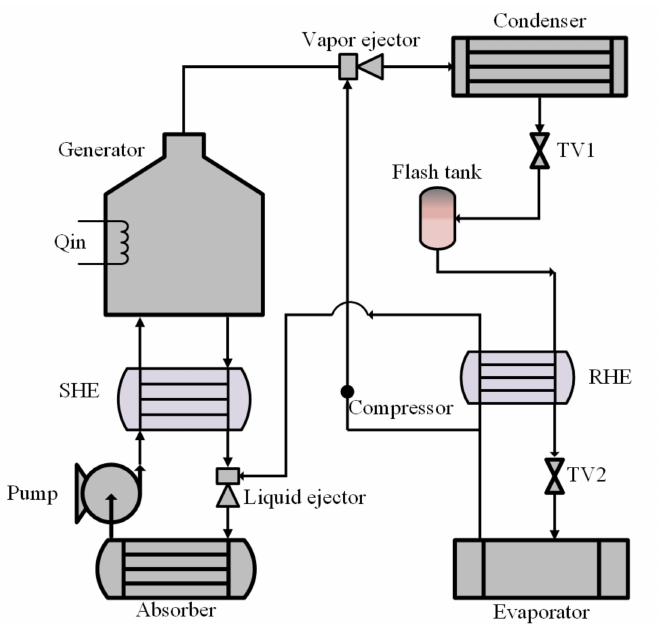
Figure 15. DEARS with SHE, RHE, and small compressor